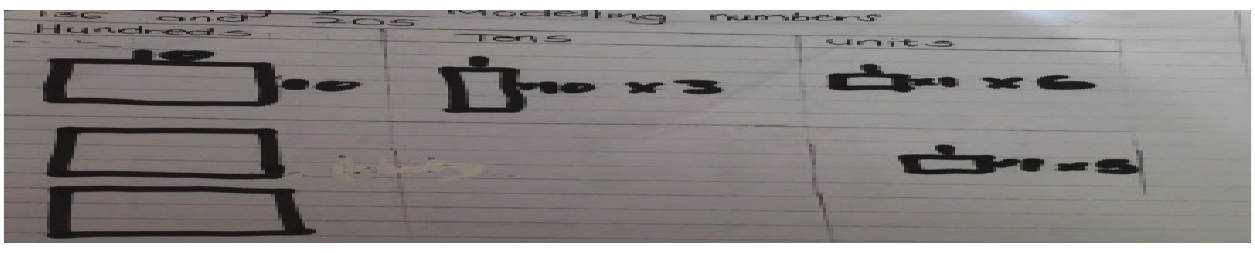
FIGURE 11: Sample of students’ response to item